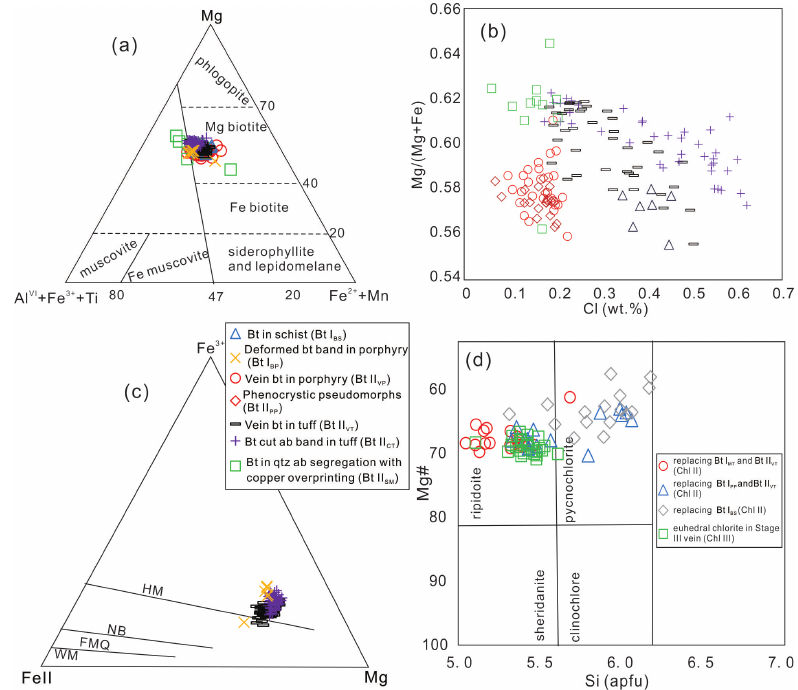
Figure 8. ( a ) Mg − (Al VI + Fe 3 + + Ti) − (Fe 2 + + Mn) ternary diagram for biotite of the Tongkuangyu Cu deposit, North China Craton; ( b ) A Mg/(Mg + Fe) versus Cl plot for biotite; ( c ) Fe 3 + - Fe 2 + - Mg ternary diagram for oxygen fugacity estimation of biotite; ( d ) A plot of Mg (cid:93) versus Si atoms for classification of chlorite at Tongkuangyu. MH: Magnetite-hematite buffer, NB: Nickel-bunsenite; FMQ: Fayalite-magnetite-quartz; WM: Wüstite-magnetite; Mg (cid:93) = Mg/(Mg +